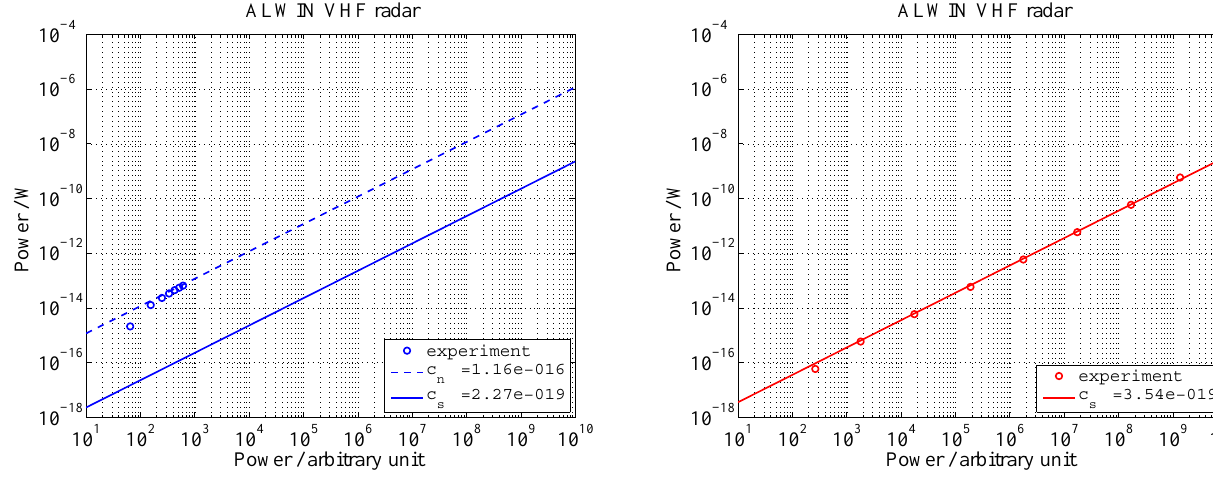
Fig. 4. Calibration with a noise source: signal power in physical units (Watt) vs. signal power in arbitrary units (circles and dashed line). Calibration curve (solid line) for coherent atmospheric echoes based on 16bit coded transmit pulses and integrated by a factor of 32 during reception.